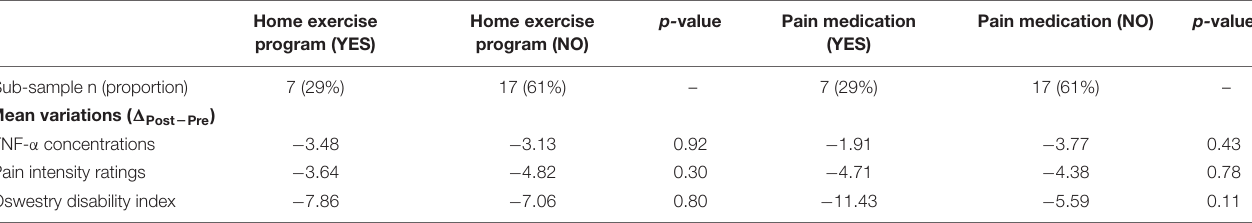
TABLE 3 | Before and after treatment variations in TNF- α concentrations, pain intensity and disability in patients following or not following a home exercise program, and using or not using pain medication during the study. Home exercise Home exercise p- value Pain medication Pain medication (NO) p- program (YES) program (NO) (YES)